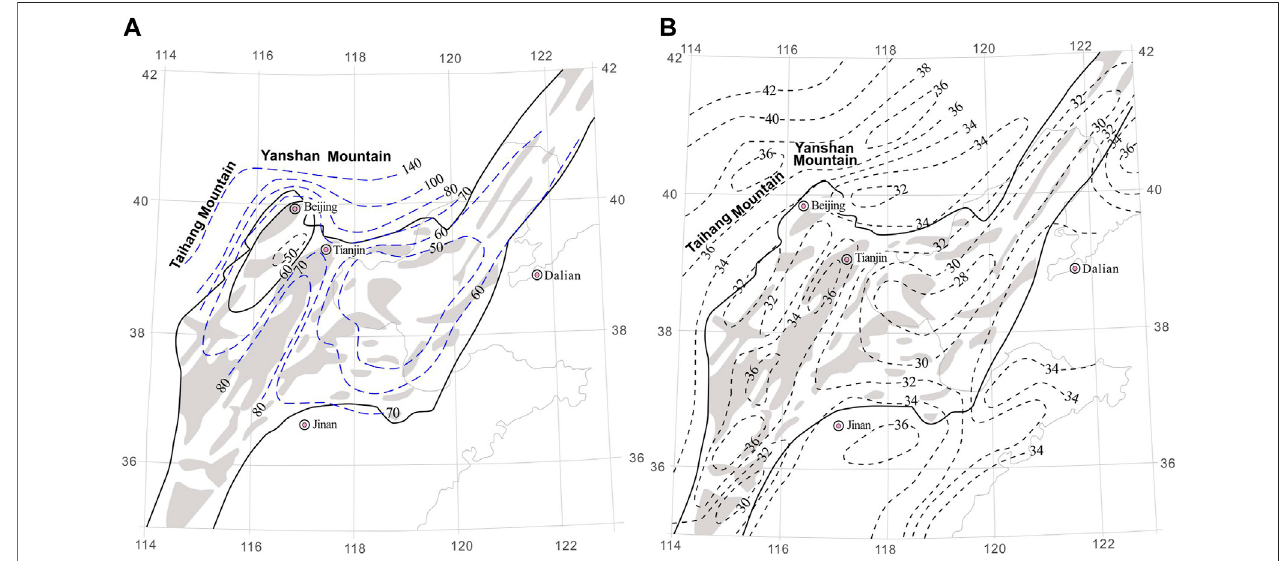
FIGURE 6 | The top surface of the asthenosphere (A) and the Moho isobaths (B) in the Bohai Bay basin (modi fi ed from Liu and Liu, 1982).